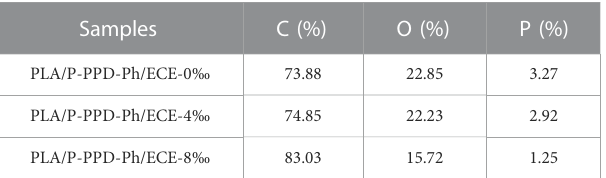
TABLE 4 Contents of C, O, and P in the EDS test of PLA/P-PPD-Ph/ECE fl ame retardant composites. Samples C (%) O